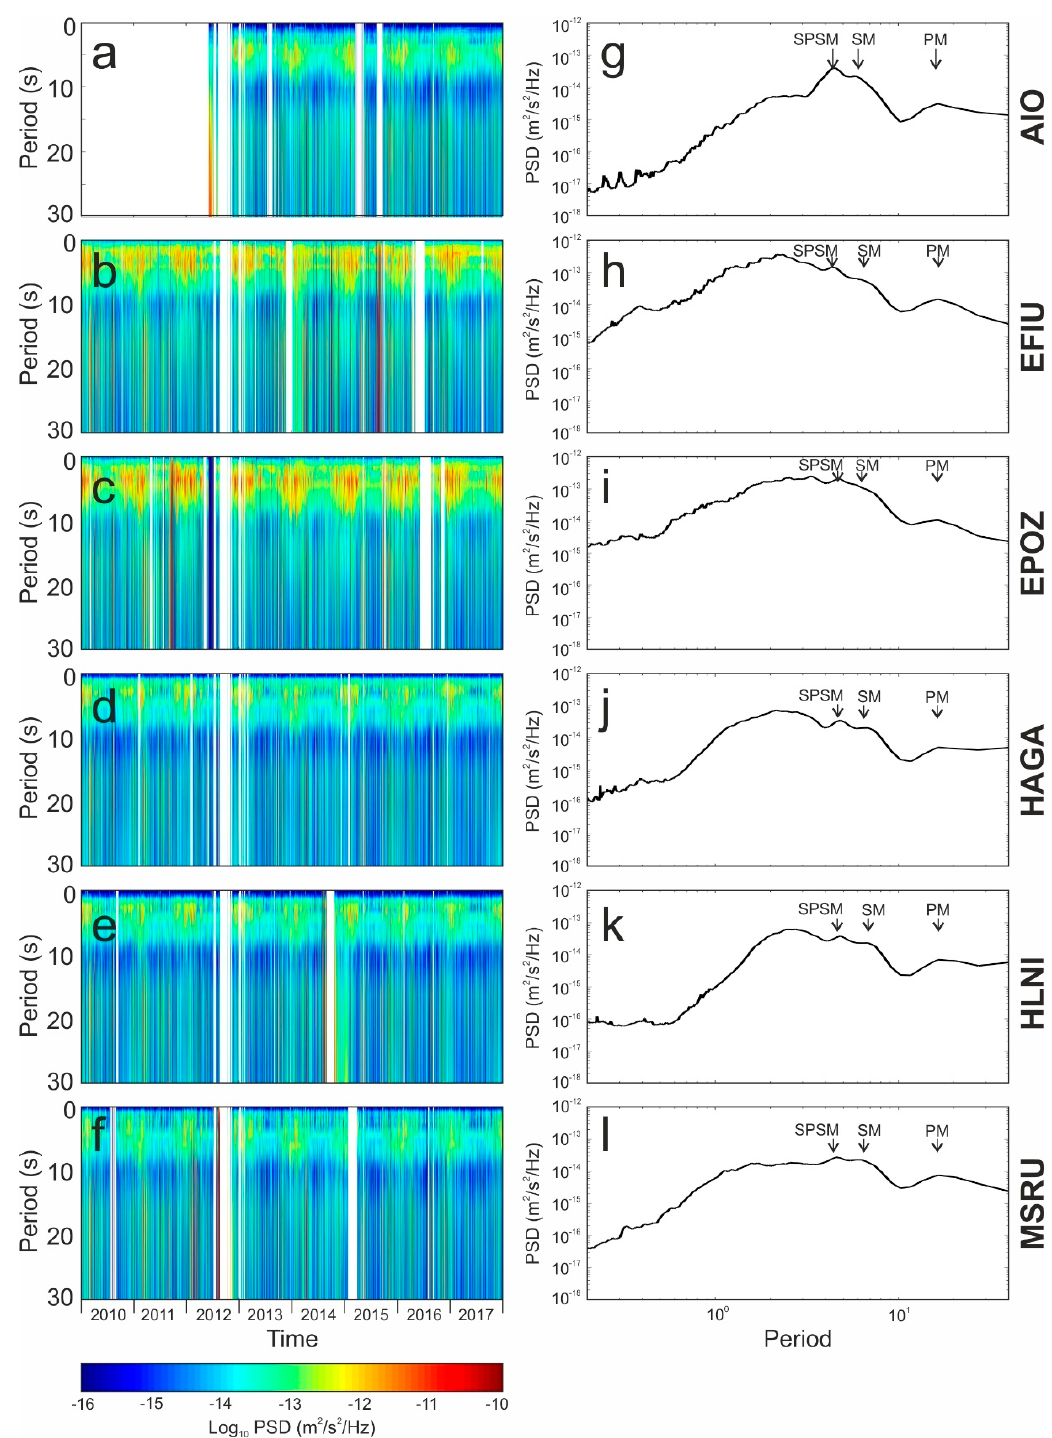
Figure 2. ( a – f ) Spectrograms of the seismic signal recorded by the vertical component of the six considered stations. ( g – l ) Median spectra of the seismic signal recorded by the vertical component of the six considered stations. Arrows and labels in ( g – l ) indicate the spectral peaks corresponding to short-period secondary microseisms (SPSM), secondary microseisms (SM) and primary microseisms (PM).